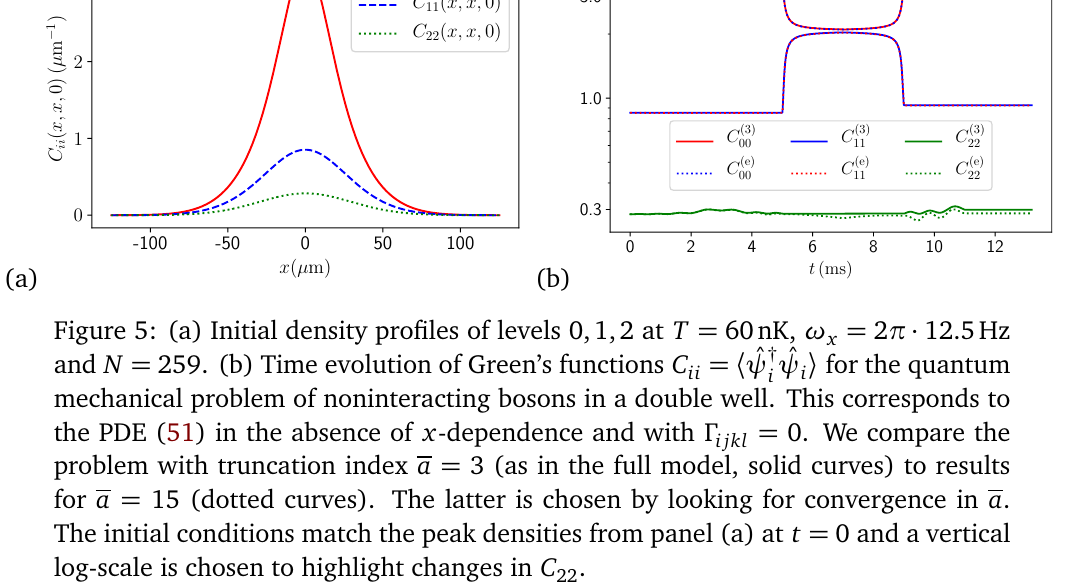
Figure 5: (a) Initial density profiles of levels 0,1,2 at T = 60nK, ω and N = 259. (b) Time evolution of Green’s functions C mechanical problem of noninteracting bosons in a double well. This corresponds to the PDE (51) in the absence of x -dependence and with Γ problem with truncation index a = 3 (as in the full model, solid curves) to results for a = 15 (dotted curves). The latter is chosen by looking for convergence in a . The initial conditions match the peak densities from panel (a) at t = 0 and a vertical log-scale is chosen to highlight changes in C